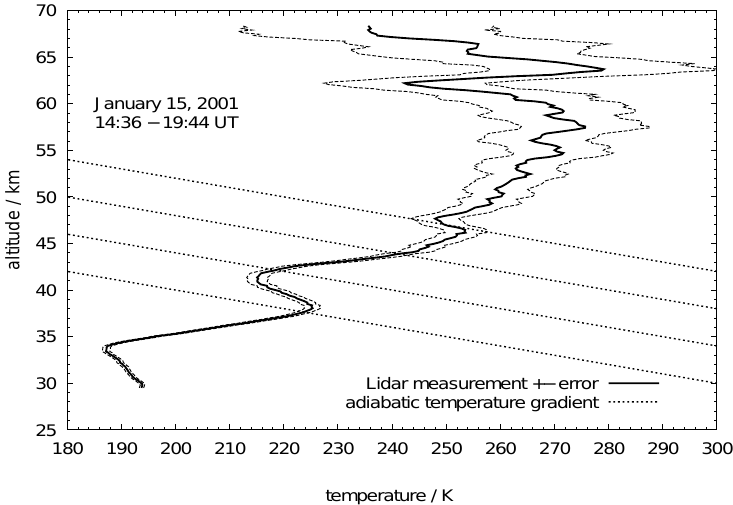
Fig. 10. Temperature profile (solid line) and error with superposed waves measured by the U. Bonn lidar on 15 January 2001. The data cover an integration time of five hours from 14:36–19:44 UT. Additionally plotted is the adiabatic temperature gradient (dotted